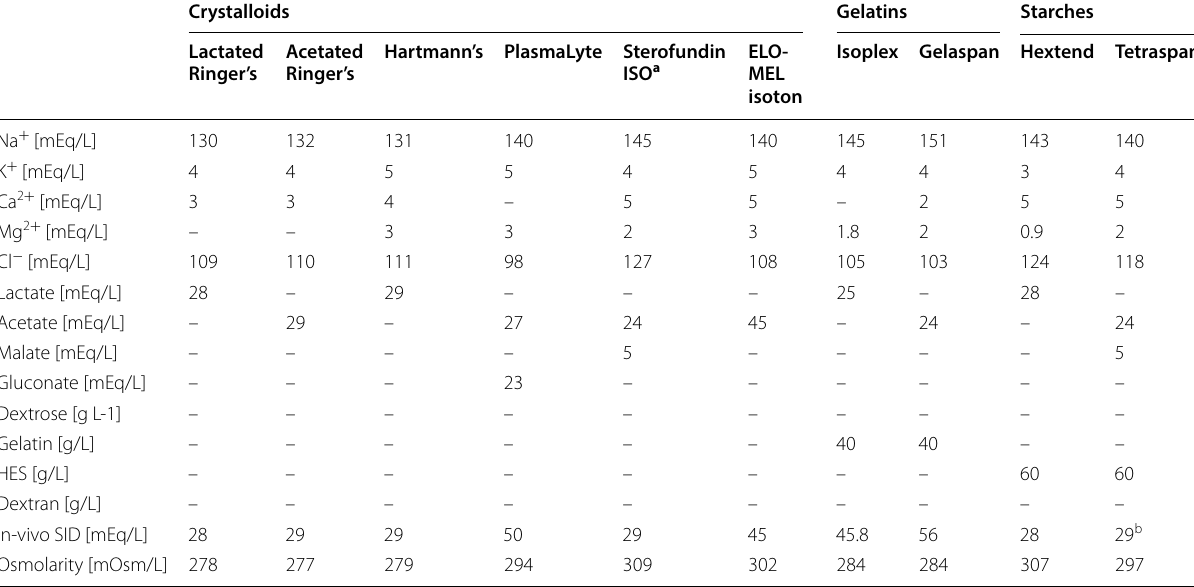
In-vivo SID—all organic molecules contained in balanced solutions are strong anions. The resulting calculated SID (in vitro-SID) is equal to 0 mEq/L, due to electrical neutrality. Once infused, the organic molecules are metabolized to CO 2 and water; the resulting in vivo-SID corresponds to the amount of organic anions